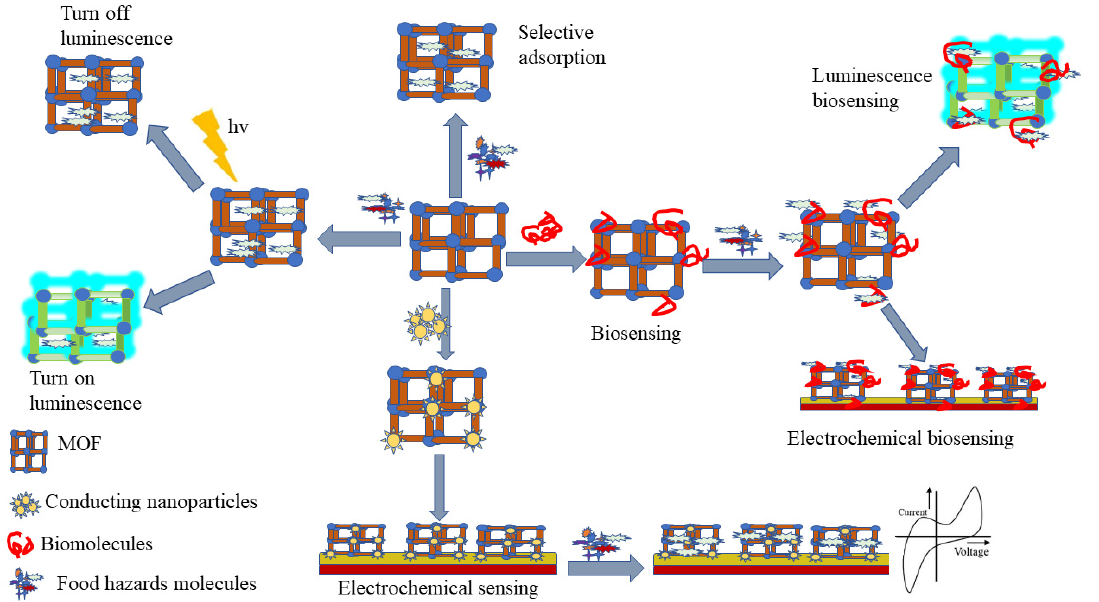
Figure 3. Schematic representation of various MOF-based techniques used for food safety analysis.